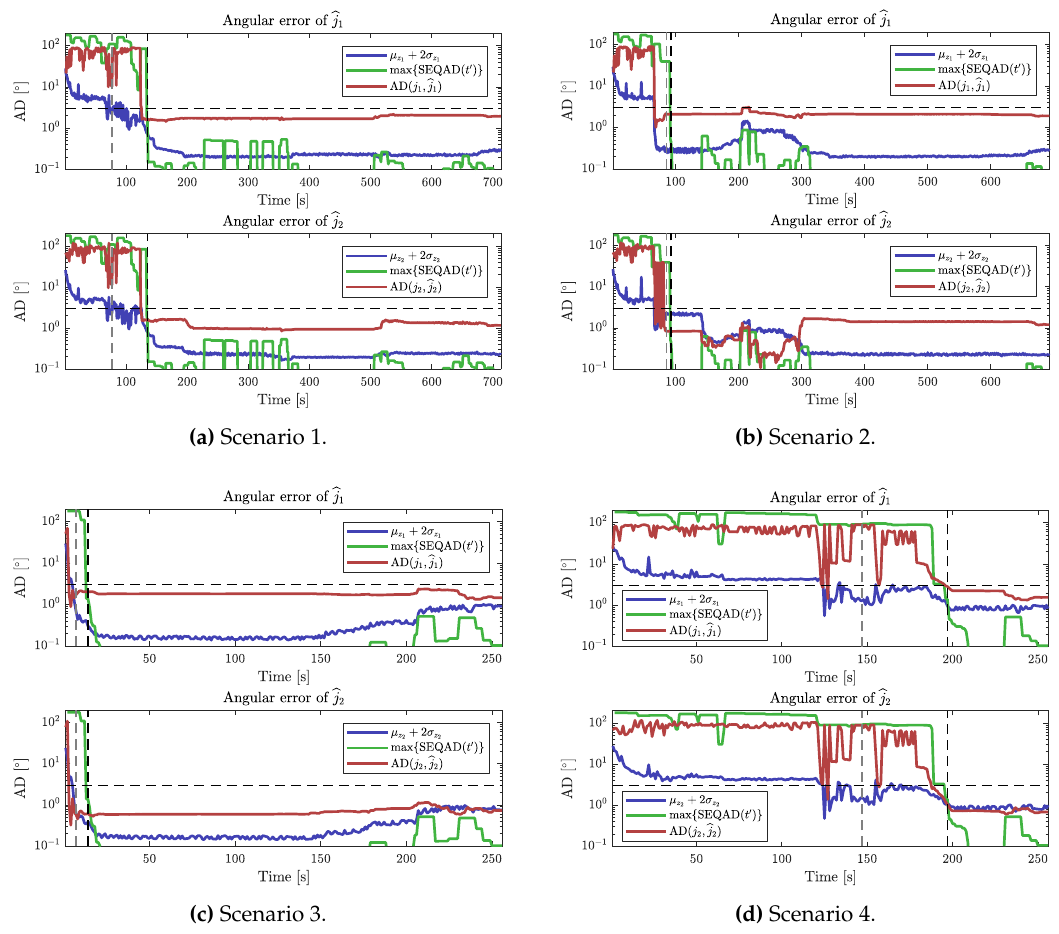
Figure 8. The plots shows the local and global uncertainty metrics compared to the angular errors (red) for the four scenarios, see ( a – d ). Local uncertainty is quantified by µ z + 2 σ z , where µ z is the estimated mean AD (64) and σ z is the standard deviation, computed from the estimated covariance matrix (65). Local uncertainty (blue) is shown for both (cid:98) j 1 and (cid:98) j 2 for each scenario. Global uncertainty is quantified by (68). The global uncertainty (green) with n min = 10 is shown for each scenario. Horizontal dashed lines show the accuracy threshold E max = 3 ◦ . Vertical dashed lines show when estimates (cid:98) j were accepted by Algorithm 4. For each scenario, the leftmost vertical lines show the case of n min = 3 and the rightmost vertical lines show the case of n min = 10, where Algorithm 4 terminates when the estimates have reached the desired accuracy w.r.t. ground